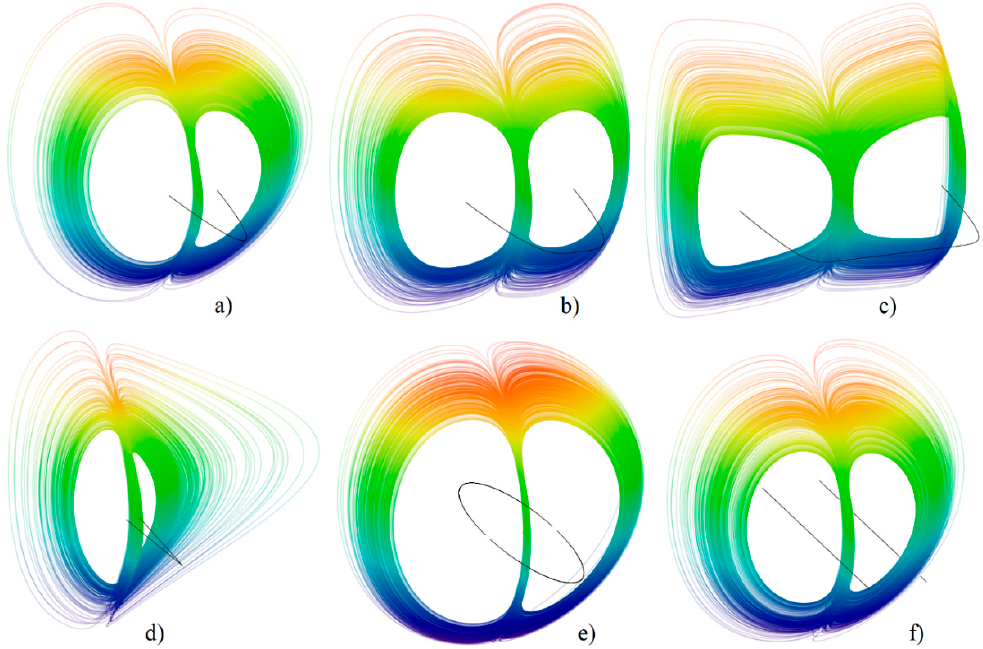
Figure 3. Typical strange attractors with different shapes of equilibrium structure located on the z plane: ( a ) original hyperbolic function (state variable y powered by two); ( b ) state variable y powered by four; ( c ) state variable y powered by fourteen; ( d ) approximation of hyperbola by the absolute value function; ( e ) circle given by equation x 2 + y 2 = 1; ( f ) a couple of the line segments defined by y = ±1.